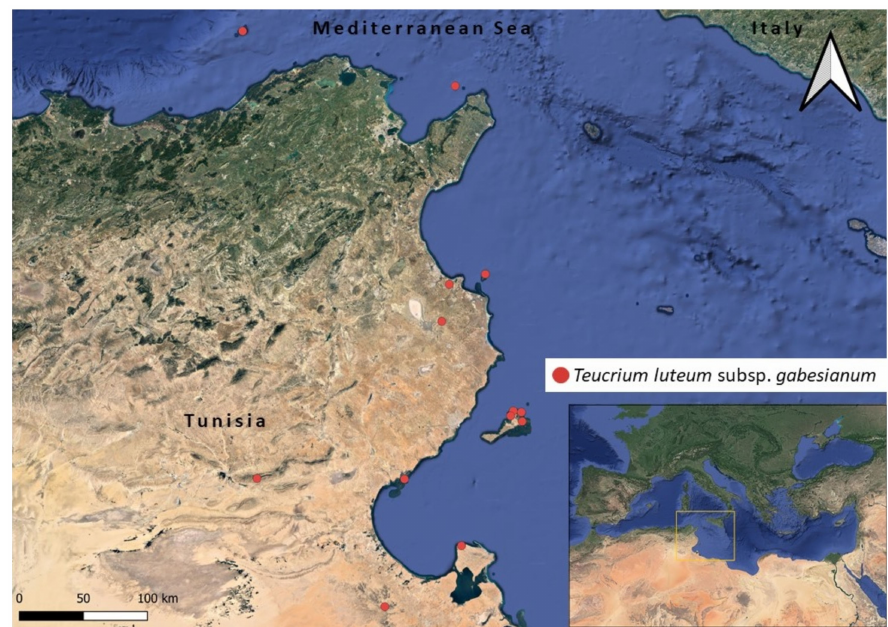
Figure 1. Overview of the known range (distribution points with red color) of Teucrium luteum subsp. gabesianum (local endemic of Tunisia) occurring in Bordj Toual and Gabes [17], Kerkennah Islands [45], Sefnou, Gremdi and Roumadiya [47], El Ataya (this study), Grande Kuriate Island [46], Kerker and Mesjed-Aïssa [47], Matmatas and Gafsa [17,49], and Djerba Island